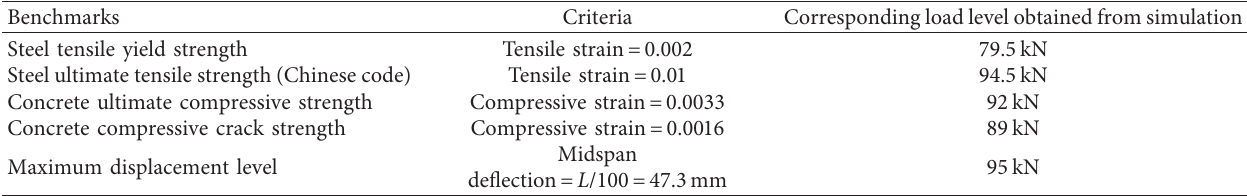
Figure 11: Response of a simple beam subjected to a point load. Table 2: Benchmarks of a simple